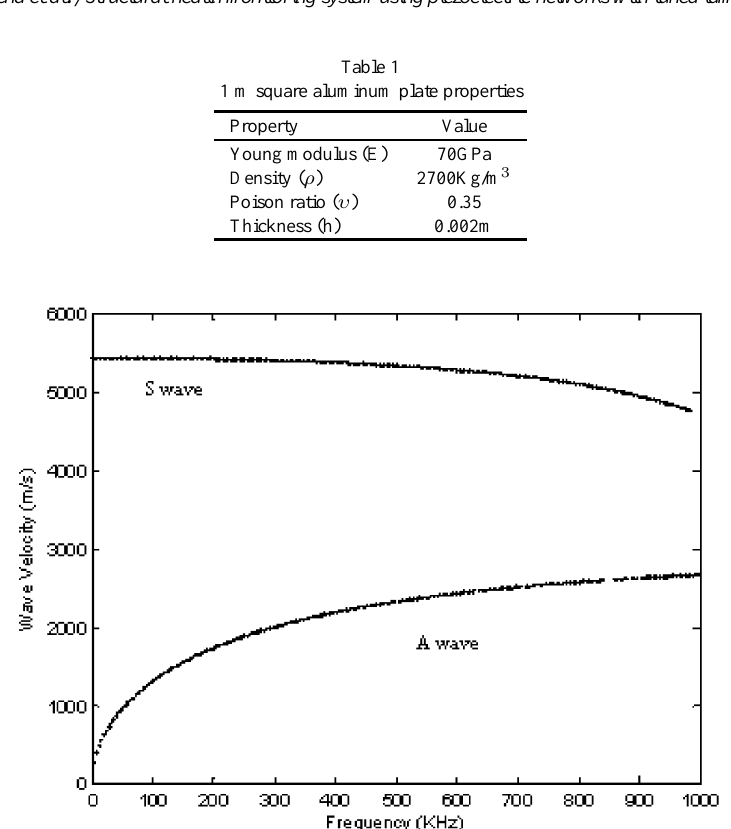
Fig. 3. Phase velocities for a 2 mm thick aluminum plate.